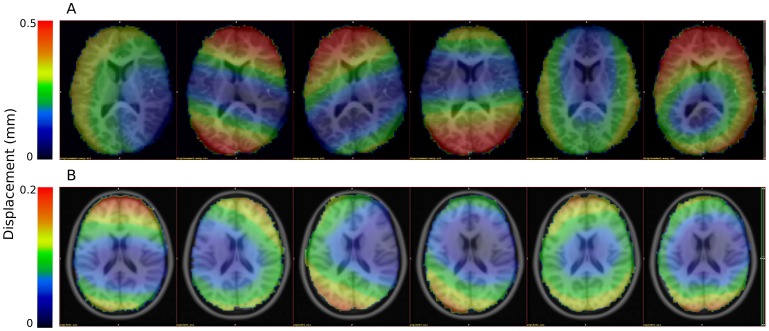
Voxel-wise characteristics of head motion during an fMRI scan.Examples of different patterns of voxel-wise displacement within the time frames of one illustrative subject (A) and temporally averaged voxel-wise displacement of six illustrative subjects (B).